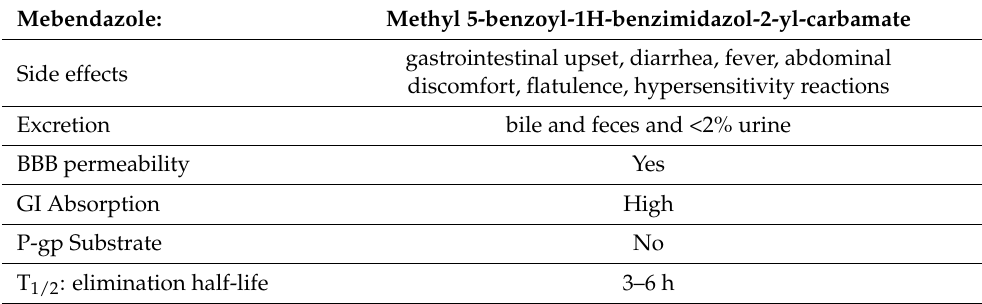
Table 1. Cont. Mebendazole: